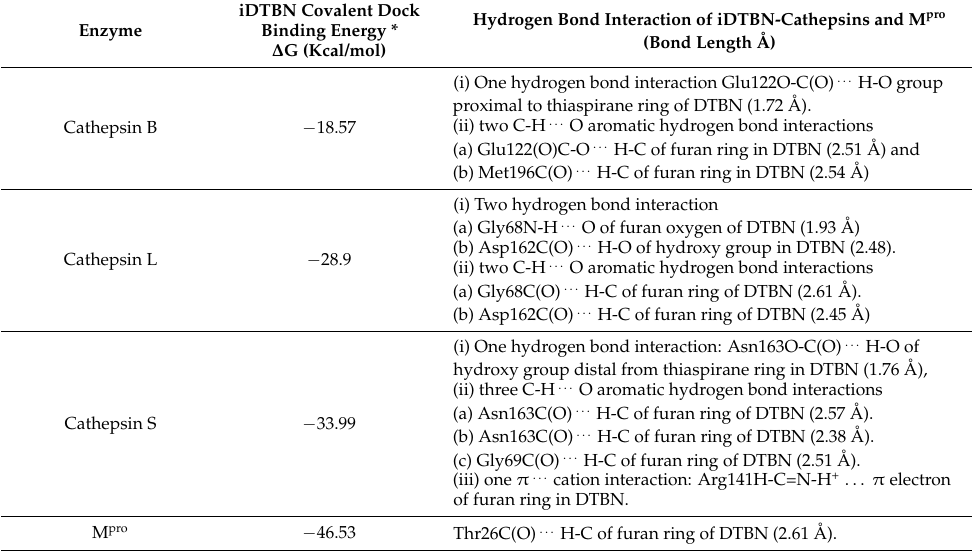
Table 2. Covalent binding Energy * ( ∆ G), of iDTBN with Cathepsins (B, L and S) and M pro .